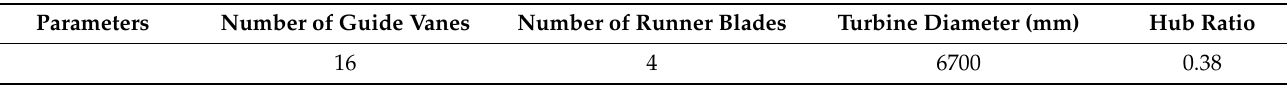
Table 3. Basic dimension parameters of turbine